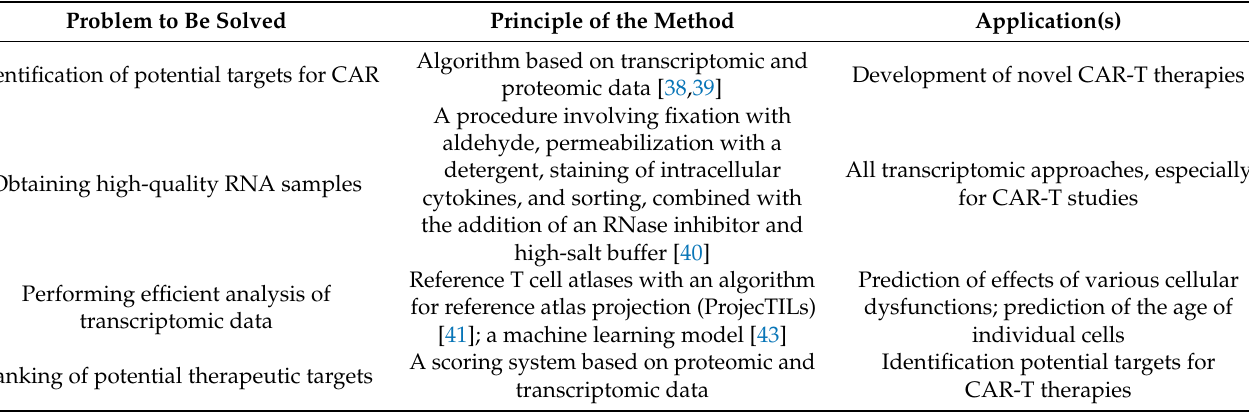
Table 2. New methods for transcriptomics in CAR-T